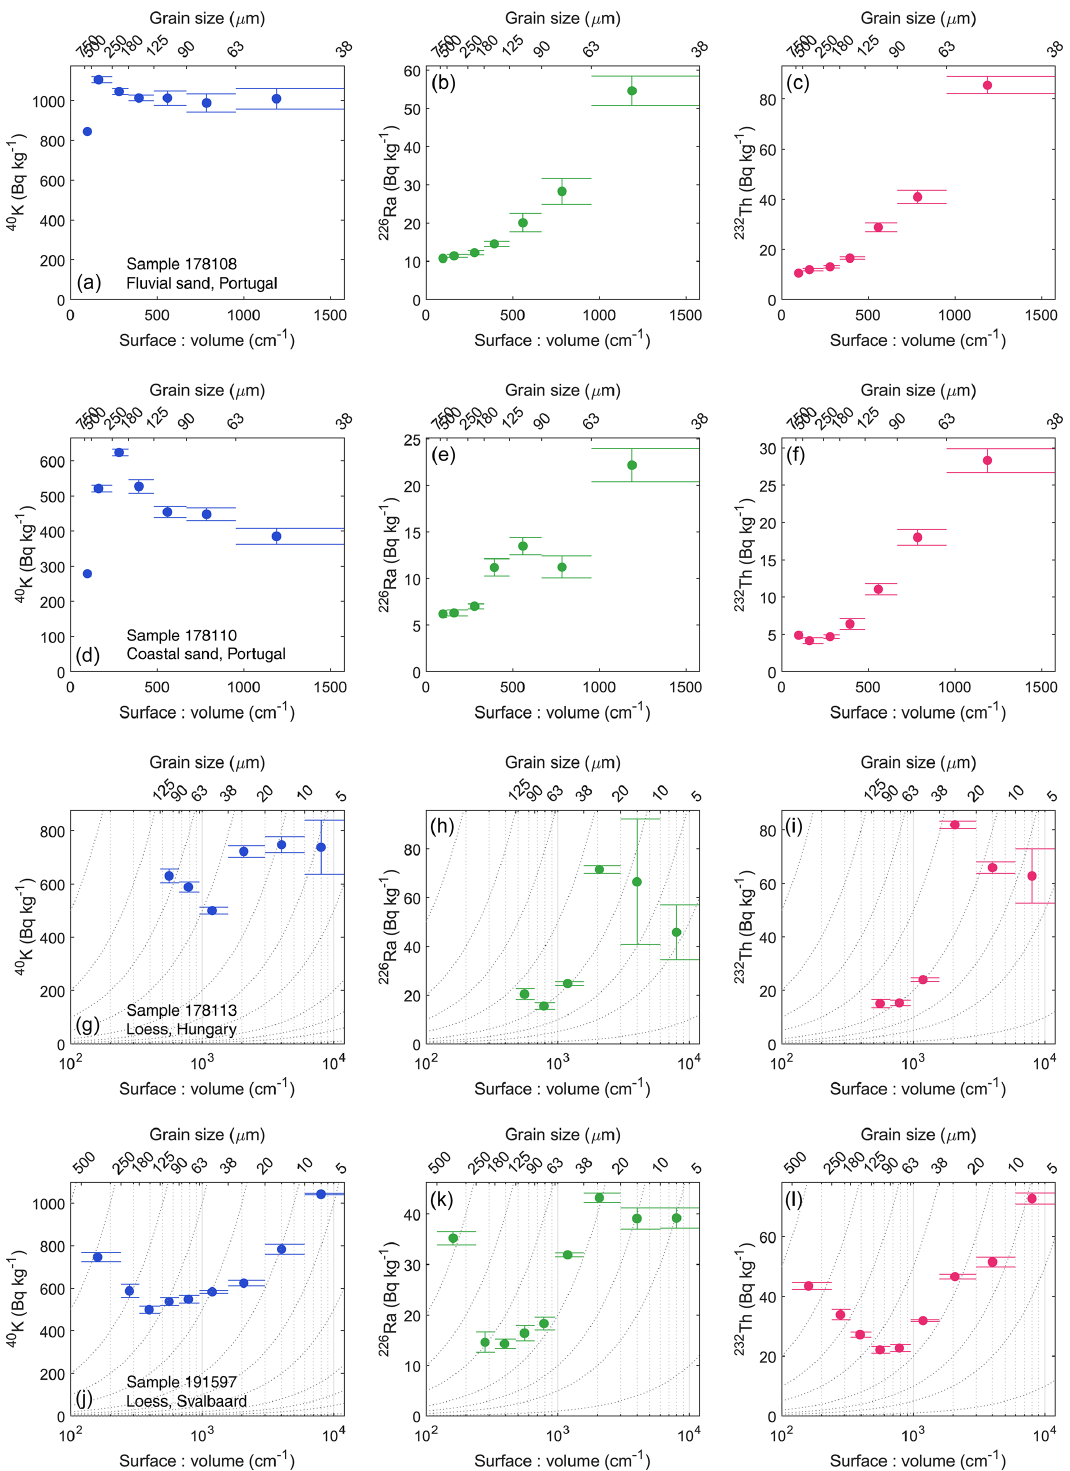
Figure 5. Activity concentrations for 40 K (left column), 226 Ra (middle), and 232 Th (right) for various grain-size fractions of four sedimentary samples measured using HpGe gamma spectrometry and plotted against the surface-to-volume ratio of the grains. The error bars in the y direction indicate the 1 σ random uncertainty in measurement. The horizontal width in the error-bar head and tail indicate the range of the grain-size fraction. Grain-size fractions are given on the secondary x axis. (a–c) Sample 178108, aeolian sand; (d–f) Sample 178110, aeolian sand; (g–i) Sample 178113, loess; and (j–l) Sample 191597, loess. Note that the lower two samples are plotted on a log scale. Proportionality is illustrated with curved